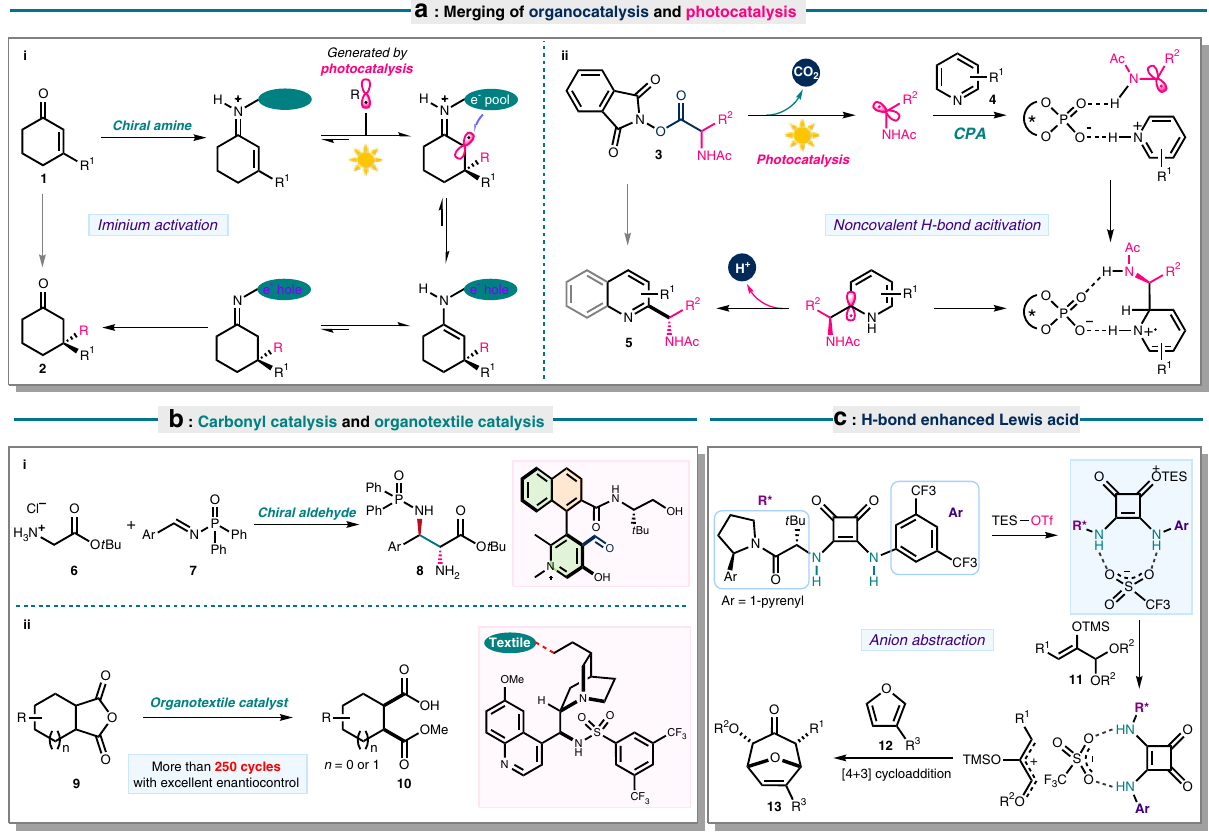
Fig. 1 Development of new catalytic strategies. a Combination of organocatalysis with photocatalysis. b Carbonyl catalysis and organotextile catalysis. c Lewis acid enhancement by H-bond donor